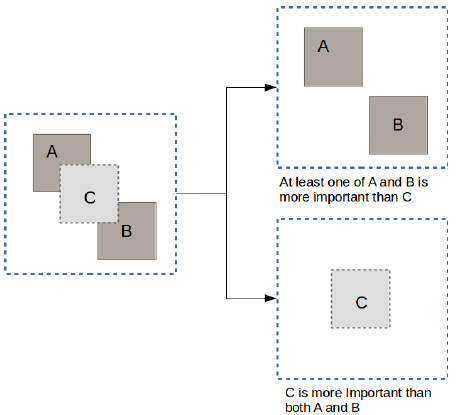
Figure 5. Multi-scale space zooming control (symadaptive.js): When the symbol C is add to the